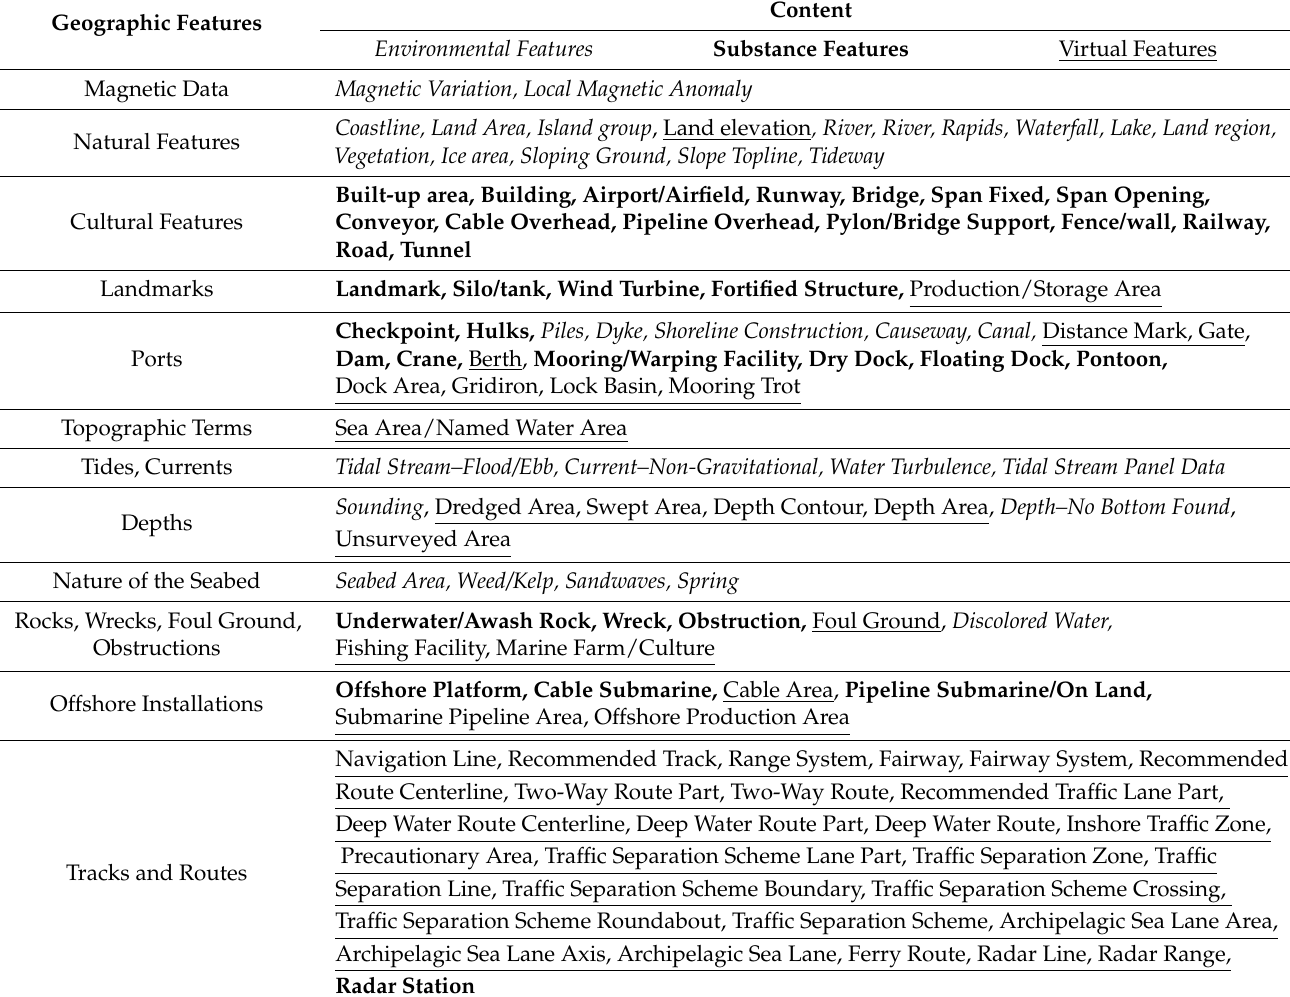
Table 1. Classification of geographic